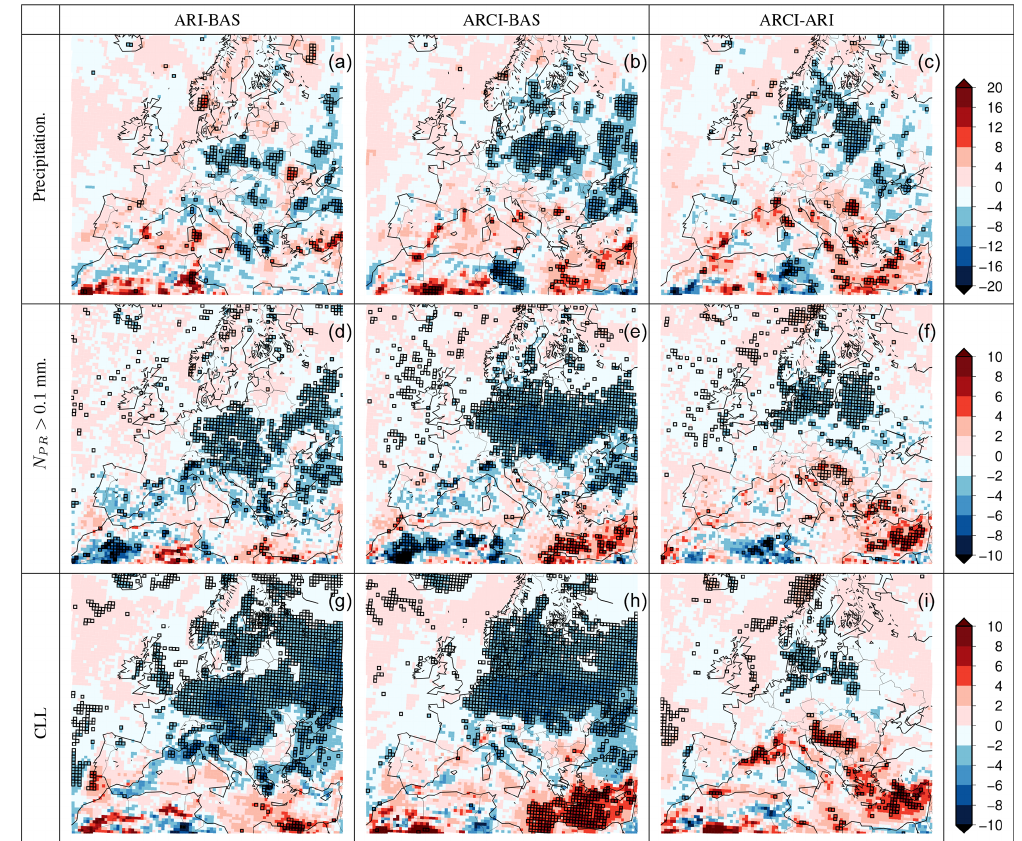
Figure 2. Relative differences for precipitation between ARI and BASE (a, d, g) , ARCI and BASE (b, e, h) , and ARCI and ARI (c, f, i) , total precipitation (a–c) number of days of precipitation > 0.1mm (d–f) , and low clouds (g–i) . Squares indicate points whose differences are significant for a p value of 0.05. The analysis was conducted for the mean values of the period